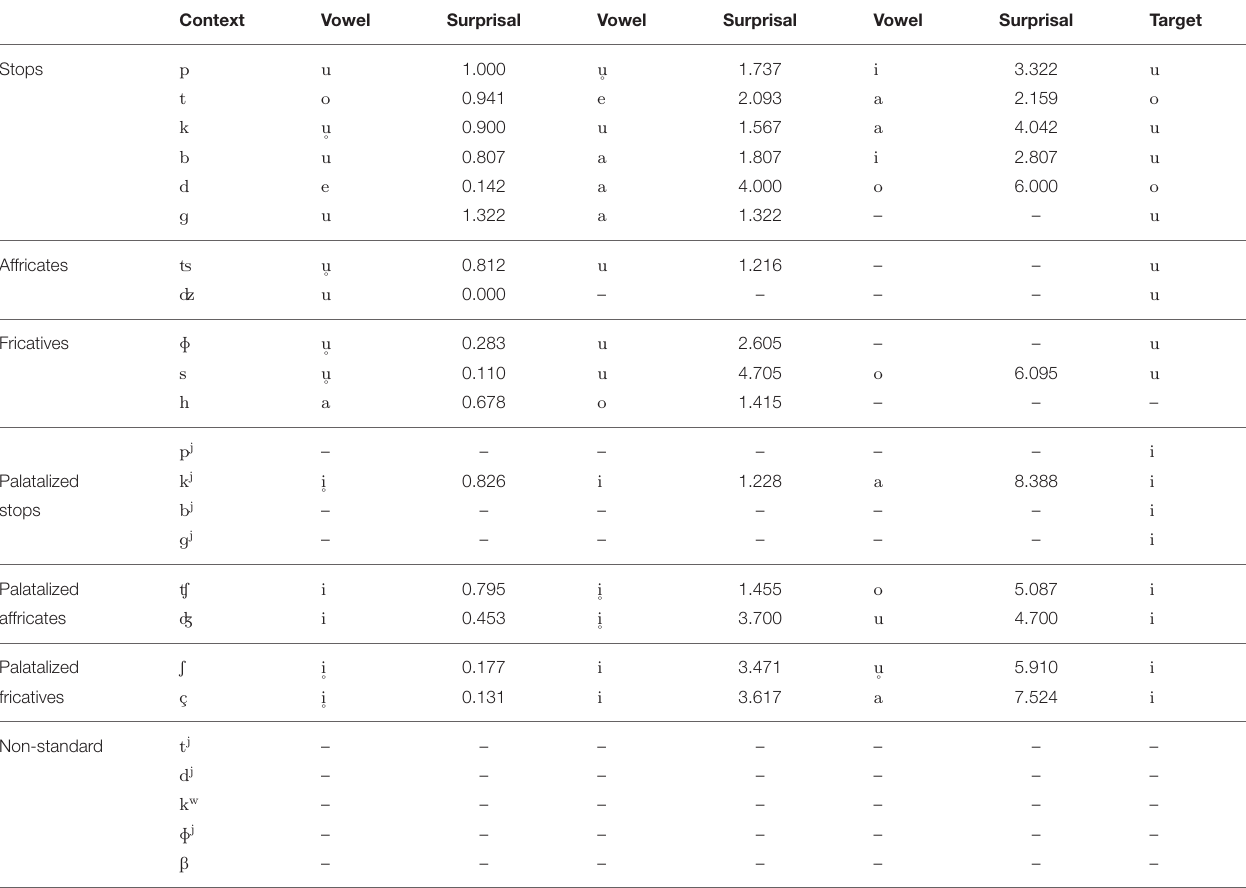
TABLE 4 | Nothing-to-vowel alternations with the three lowest surprisal after all obstruents observed in the CSJ-RDB, learned by the alternation